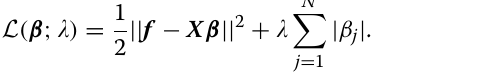
S ( x T f , (cid:31) )/ x T x , and dashed line is =